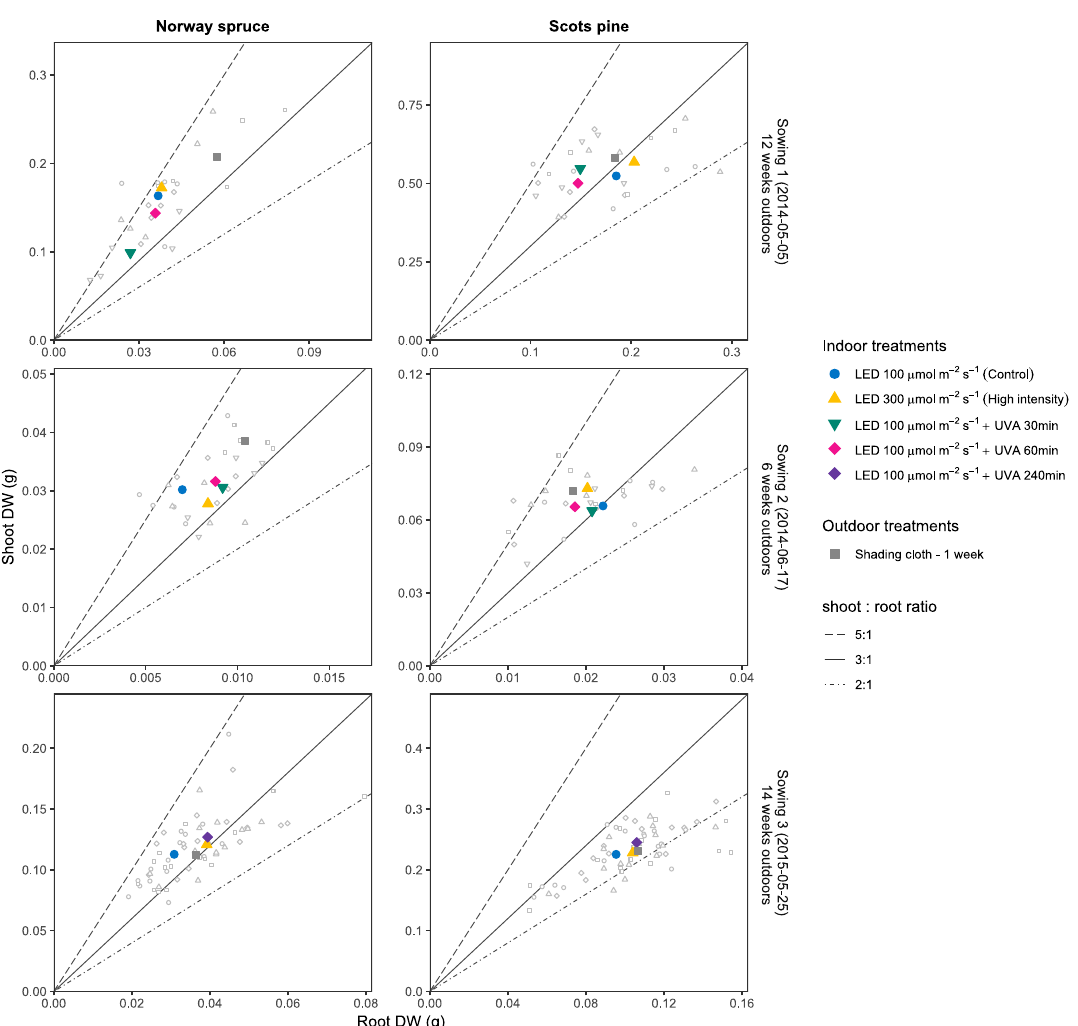
Figure 7. Average biomass distribution evaluated in function of the shoot:root ratio after the first vegetation period for seedlings of Norway Spruce ( left ) and Scots pine ( right ). Each panel row shows the results for one individual sowing with colored shapes representing the mean of each treatment in ordered pairs (x = shoot DW (g), y = root DW (g)) and smaller points show the individual seedling measurements. Solid lines mark the di ff erent shoot:root ratios (5:1, 3:1, 2:1). For Sowing 1 and Sowing 2 the UVA treatments (30 min and 60 min) were di ff erent from Sowing 3 which only included the UVA 240 min treatment as explained in the Materials and Methods Section.